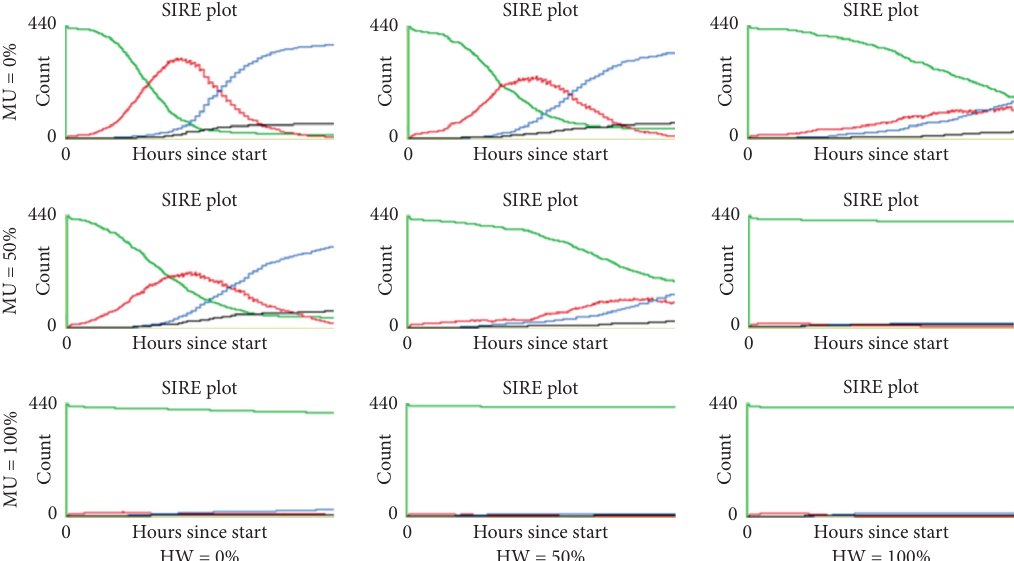
Figure 2: Representative SIRE curves for scenarios with SD � 50% and different combinations of MU and HW proportions (green, susceptible; red, infectious; blue, recovered; black, extinct).